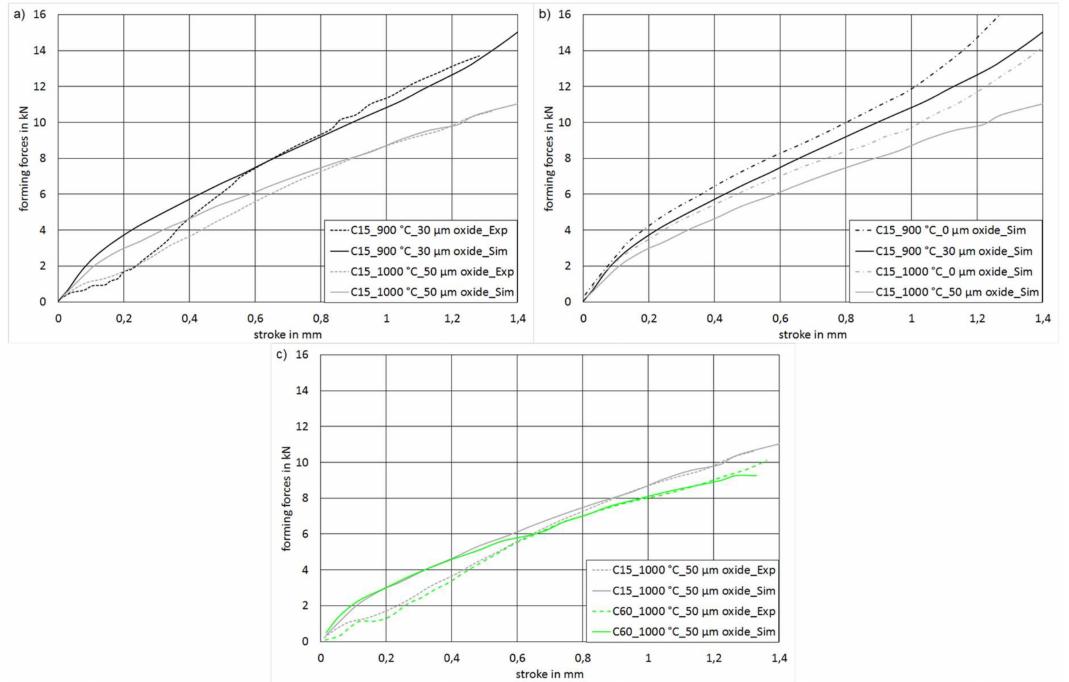
Figure 2. Comparison between simulation and experiment and the sensitivity analysis of the ring-compression test for determining the influence of ( a ) temperature and scale thickness for C15 (higher forming temperature increase oxide thickness), ( b ) oxide thickness of C15 at different temperatures (oxide scale correlate with friction and radiation), and ( c ) carbon content at 1000 ◦ C for C15 and C60 on forming